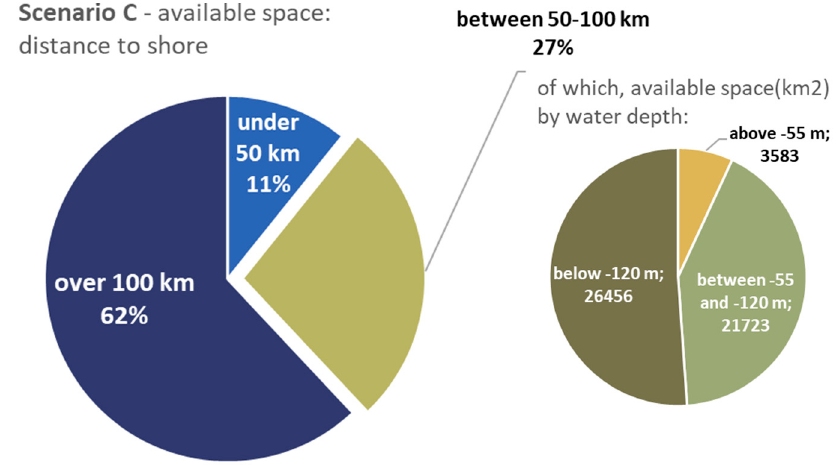
Figure 15. Percentage of available areas in relation to the distance to shore and water depth in Scenario C.